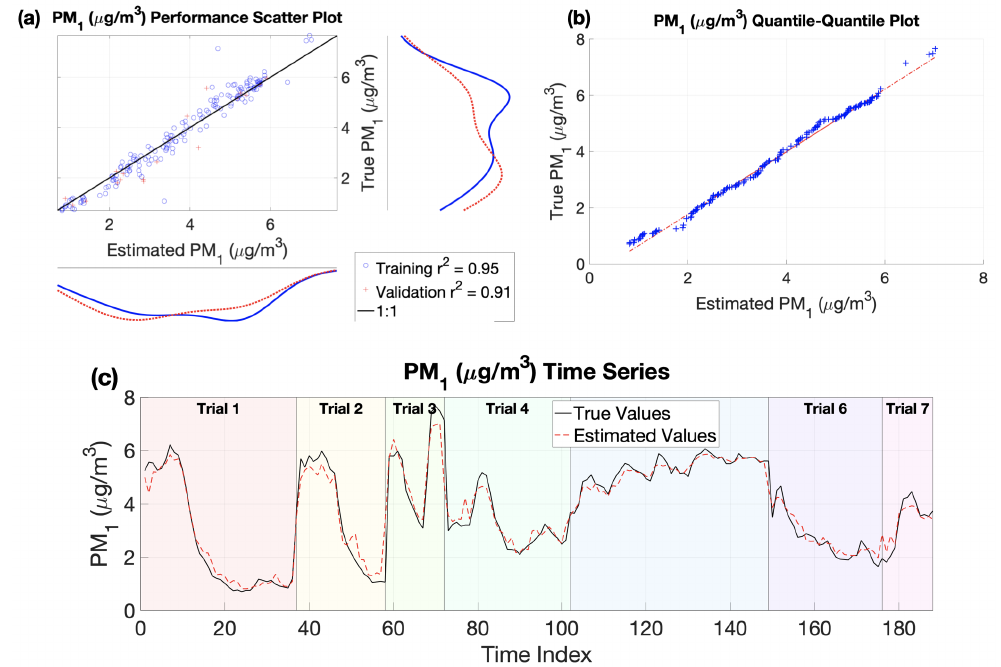
Figure 5. Top performing model (PM 1 ) plots comparing predicted and ground truth values. ( a ) Scatter plot of true versus predicted PM 1 values. A perfect fit is indicated by the 1:1 line shown in black. Training data are shown as blue circles and validation data are plotted as red pluses. ( b ) Quantile–quantile plot of true versus predict PM 1 values. Identical true and predicted distribu- tions would results in a perfect y = x line. ( c ) Time-series plot of true PM 1 values (solid black line) and predicted PM 1 values (dashed red line). Background color indicates the trial number associated with each time period. Trials 1–3 were collected on 26 May 2021; trials 4–5 were collected on 9 June 2021; and trials 6–7 were collected on 10 June